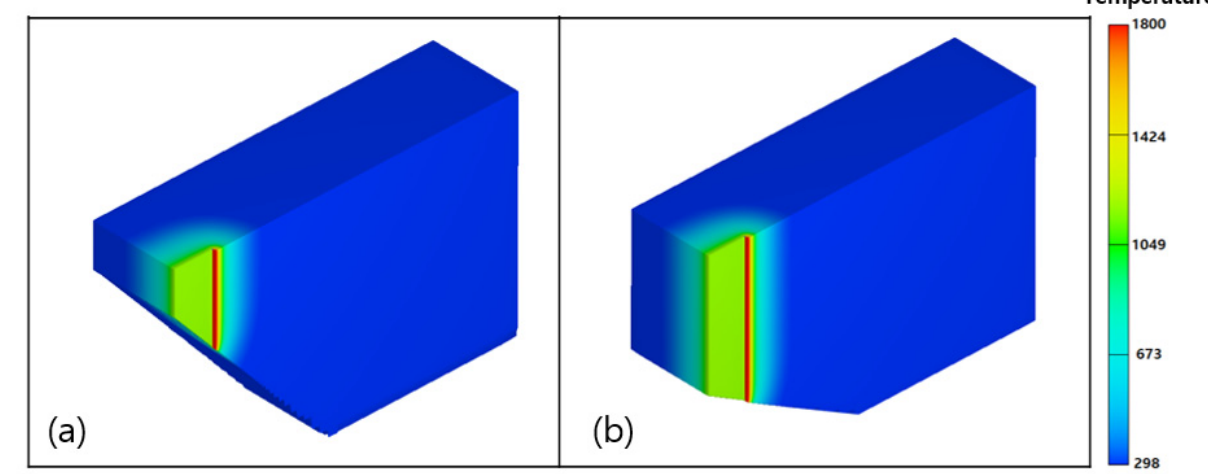
Figure 11. Numerical simulation of heat conduction for different cases: ( a ) half scale of case 2 and ( b ) half scale of case 4.